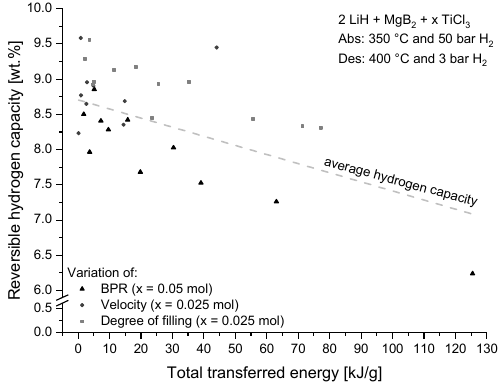
Figure 6. Reversible hydrogen capacity as a function of total transferred energy for different milling times as well as ( a ) BPRs, ( b ) milling velocities, and ( c ) degree of filling.